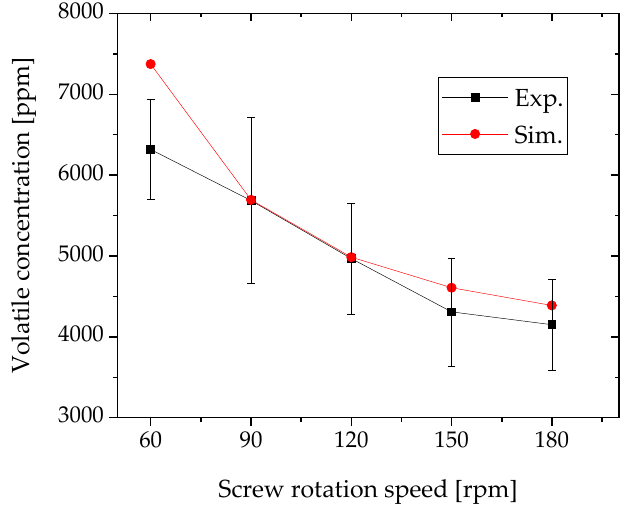
Figure 8. Comparison of simulation results and experimental results of screw rotation speed and toluene concentration (starved zone length = 1024 mm). The volatile concentration at each screw rotation speed was measured three times.